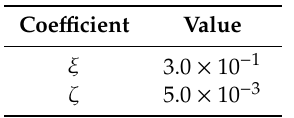
Table 1. Power Loss Coe ffi